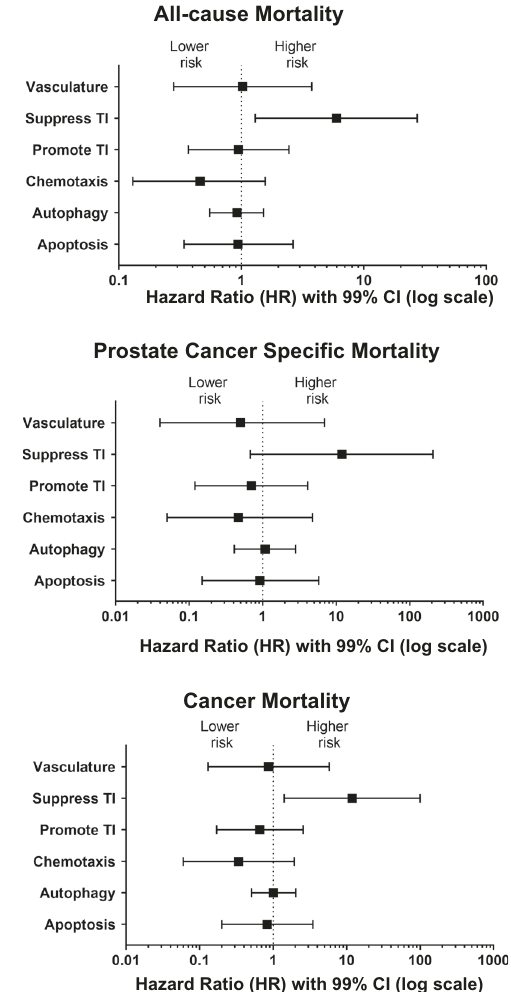
Fig. 6 Suppression of the tumor immunity pathway associates with survival of prostate cancer patients. We assessed the association of the six pathways de fi ned by the 82 immune-oncology markers with all-cause mortality ( n = 202), prostate cancer-speci fi c mortality ( n = 57), or mortality due to any cancer after a prostate cancer diagnosis ( n = 103) out of the 819 prostate cancer patients followed. The pathway scores were evaluated as continuous predictor variables. Suppression of tumor immunity pathway was distinctively associated with all-cause mortality ( a ), prostate cancer-speci fi c mortality ( b ), or a mortality due to any cancer after a prostate cancer diagnosis ( c ). Multivariable Cox regression analyses were used to assess if the pathways were independently associated with survival of prostate cancer patients in the NCI-Maryland study. For ( a – c ), the hazard ratios (HRs) were adjusted for age